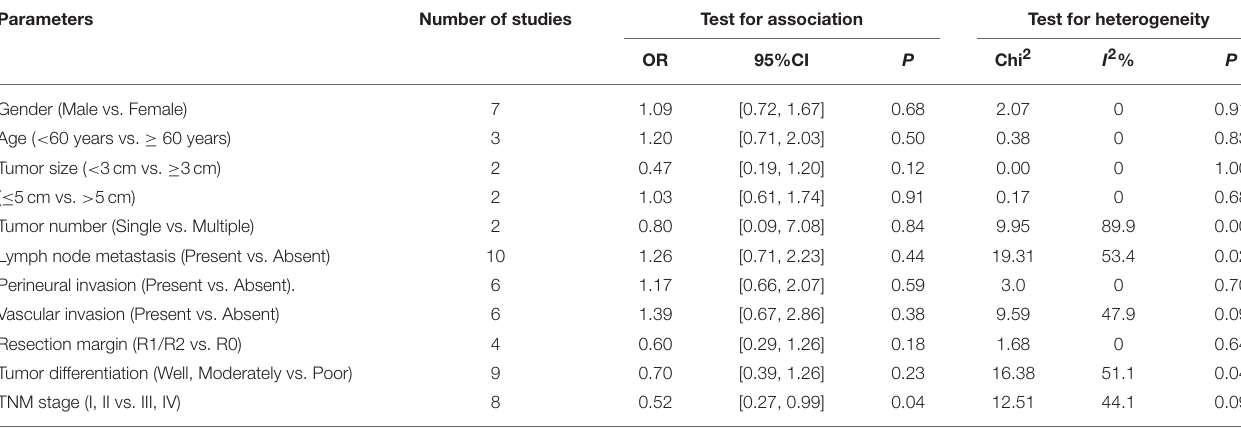
TABLE 3 | The relationship between PD-L1 in TCs and the clinicopathological features. Parameters Number of studies